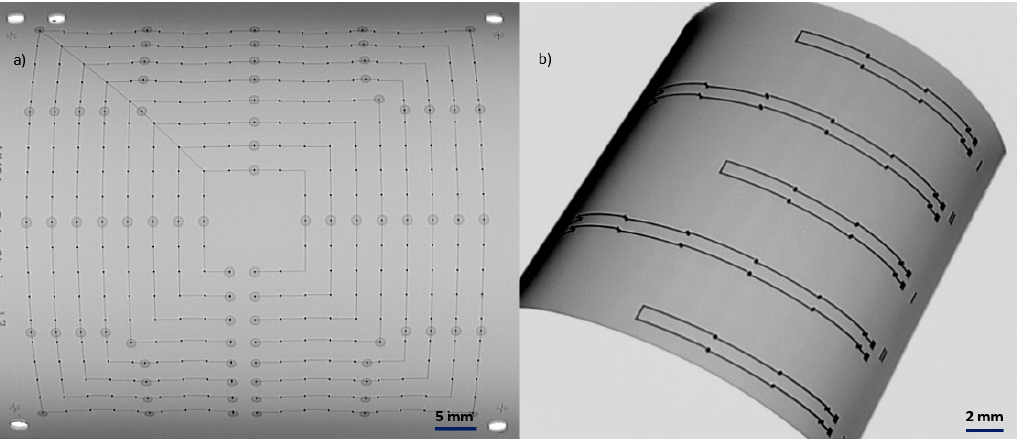
Figure 3. X-ray images of the two different daisy chains; ( a ) daisy chain sized 60 mm × 60 mm; ( b ) daisy chain sized 30 mm × 4 mm.